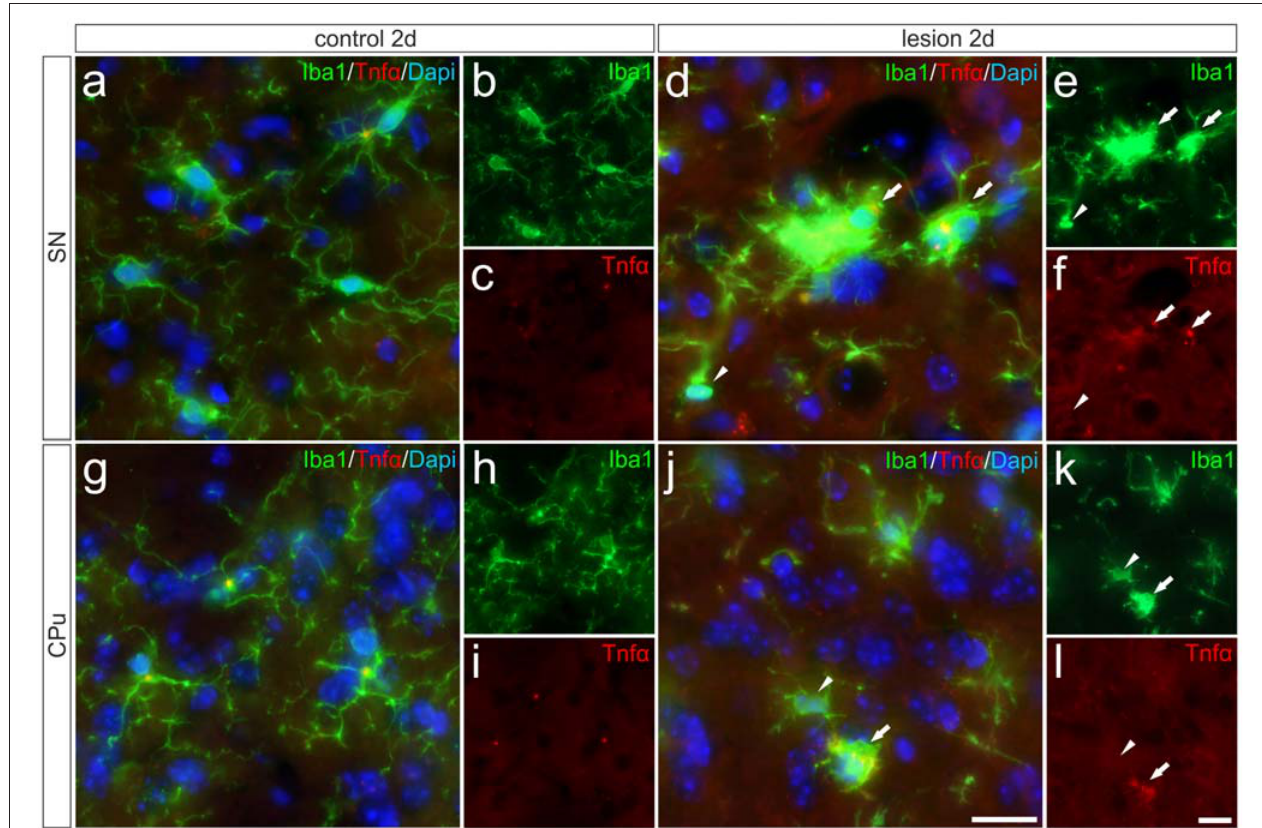
FIGURE 5 | Microglial expression of Tnf α in the SN und the CPu after 6-OHDA injections. Two days after 6-OHDA-induced lesion no Tnf α expression was observed in microglia in SN (A–C) and CPu (G–I) . However, distinct Tnf α immunoreactivity could be detected on the lesioned side. Activated microglia (white arrows) showed Tnf α expression in the SN (D–F) as well as in the CPu (J–L) . No Tnf α signals were present in ramified non-activated microglia (white arrowheads) from the SN (D–F) and the CPu (J–L) on the lesioned side. Representative images from three different animals are shown. Scale bars indicate 20 µ m.